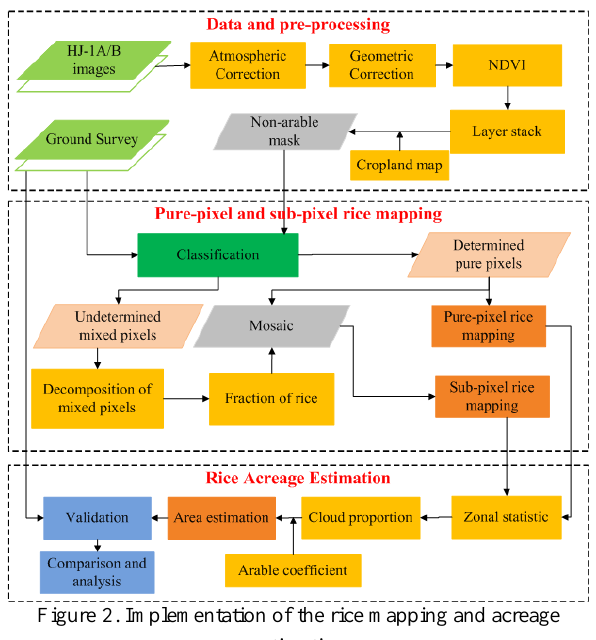
Figure 2. Implementation of the rice mapping and acreage